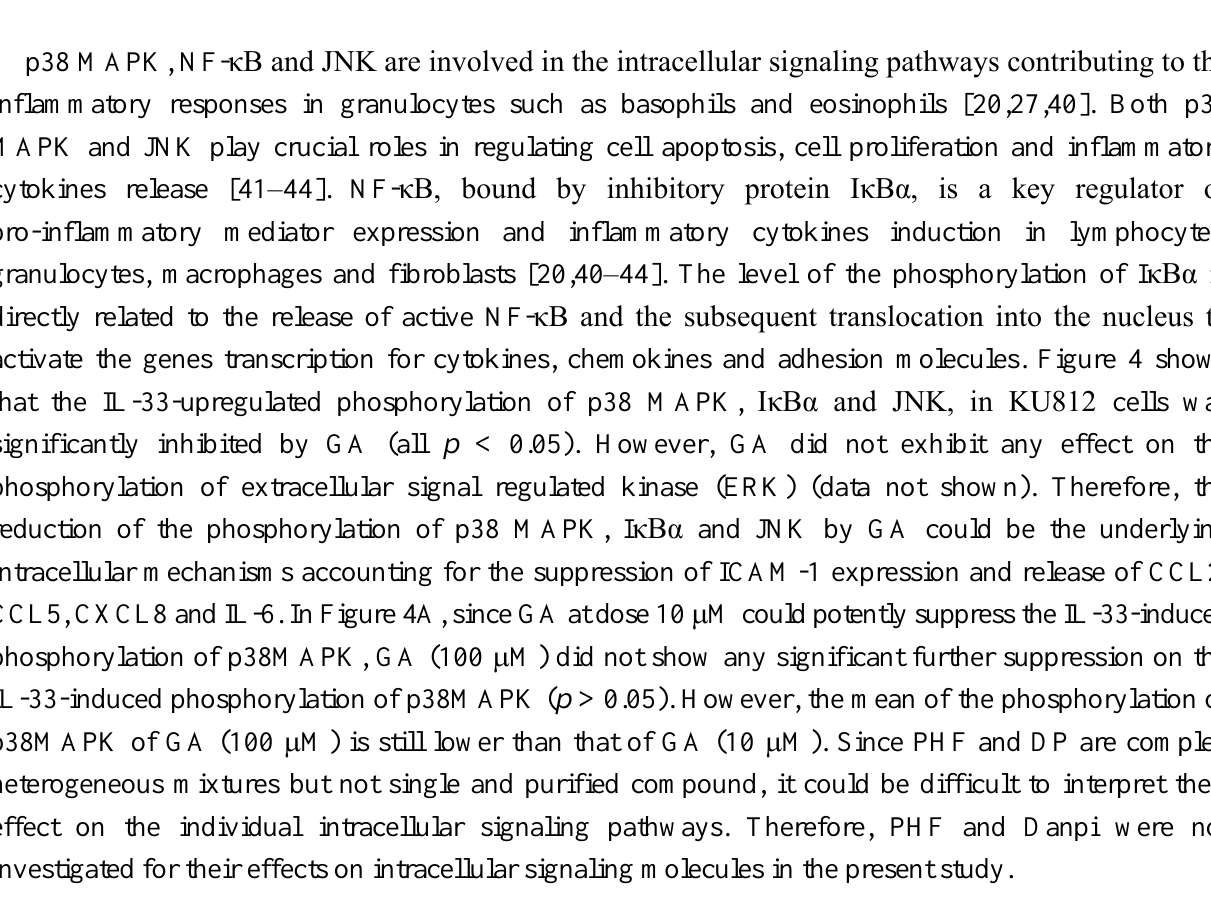
( c ) GA 2.4. Effect of GA on the Phosphorylation of Intracellular Signaling Molecules p38 Mitogen Activated Protein Kinase (MAPK), Inhibitory-κBα (IκBα) and c-Jun Amino-terminal Kinase (JNK) on IL-33 Activated KU812